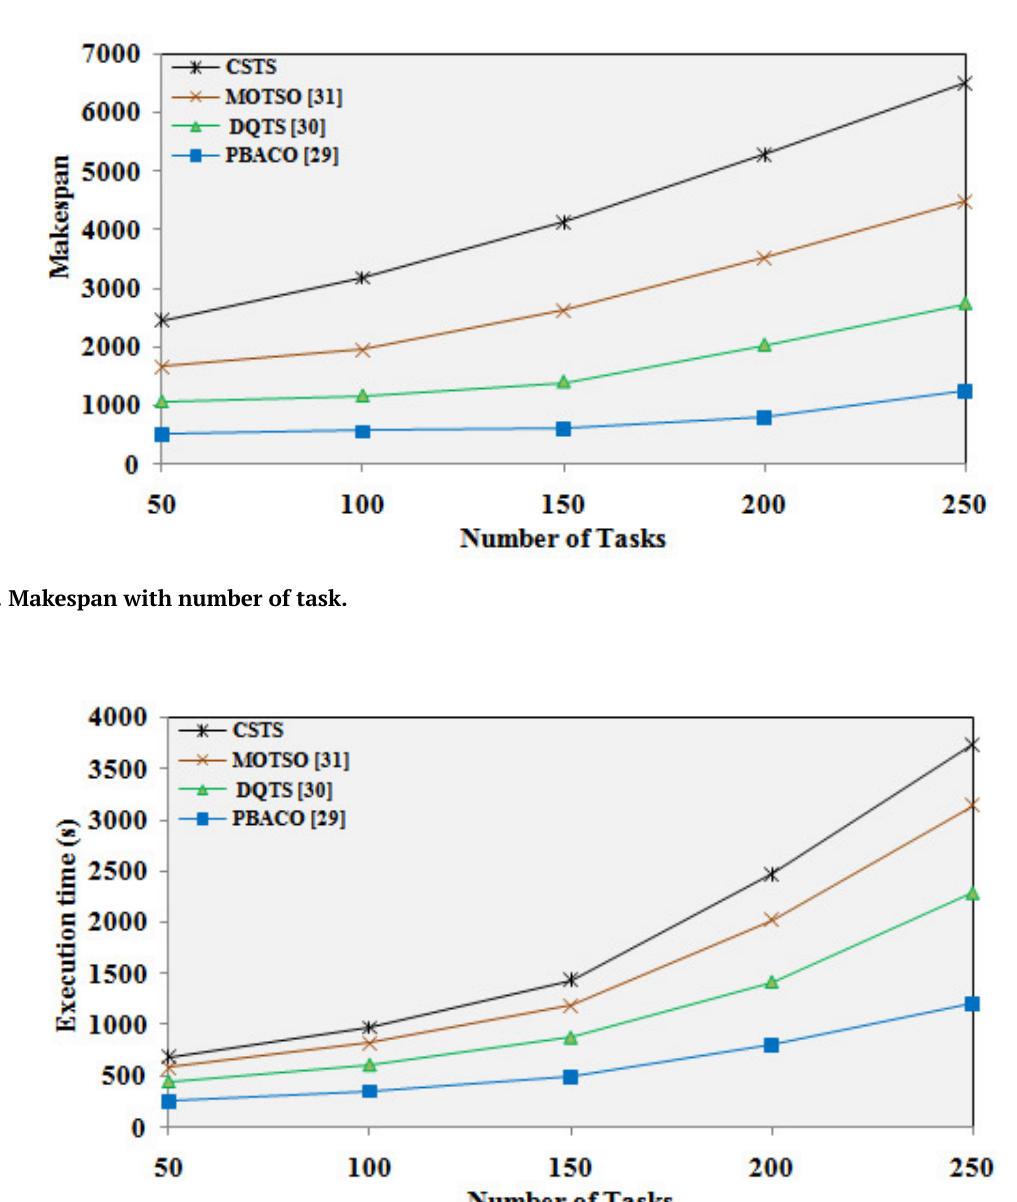
Figure 3. Execution time with number of task.